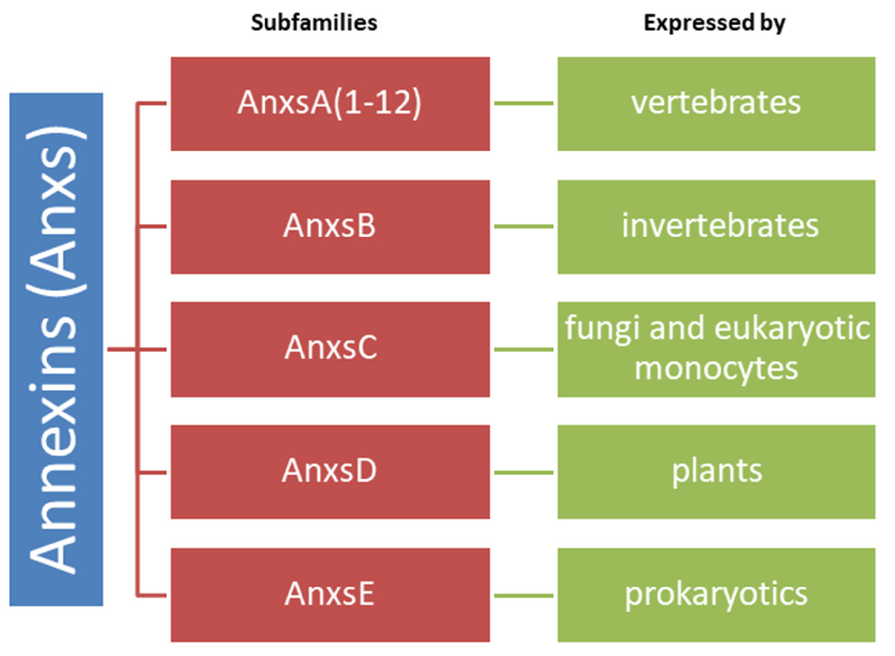
Figure 2. Annexins categories and their expression in different phyla.